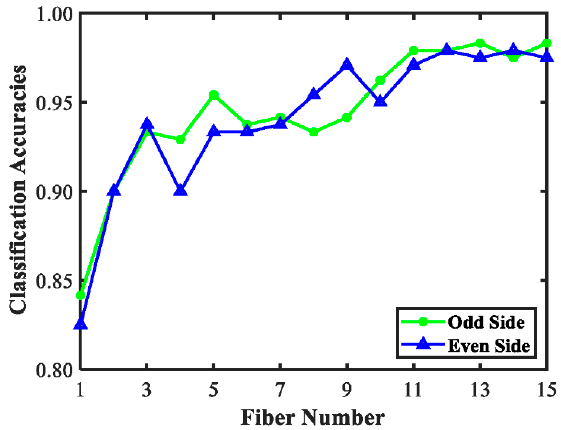
Figure 5. The total classification accuracies for recognition tomato maturity based on 15 individual SR spectra on two sides.